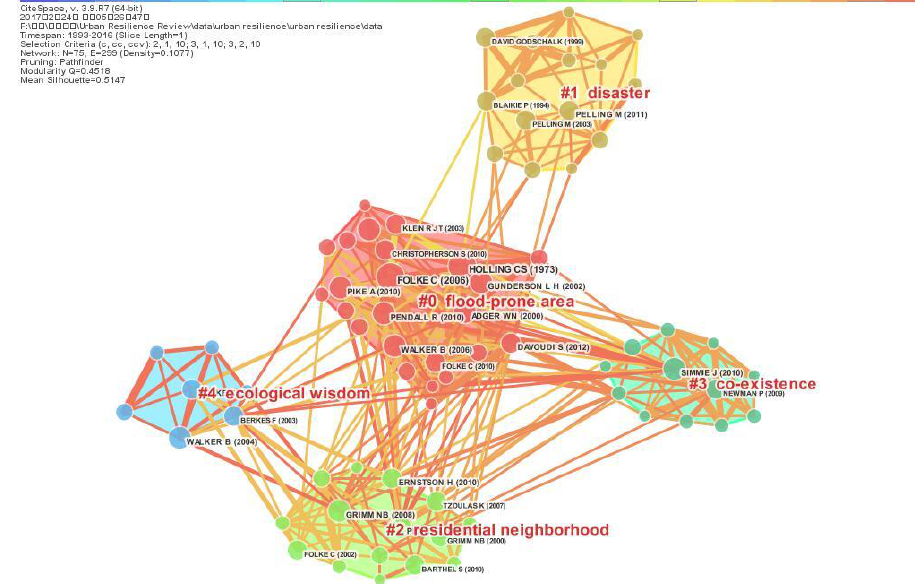
Figure 9. Cluster view of document co-citation network.